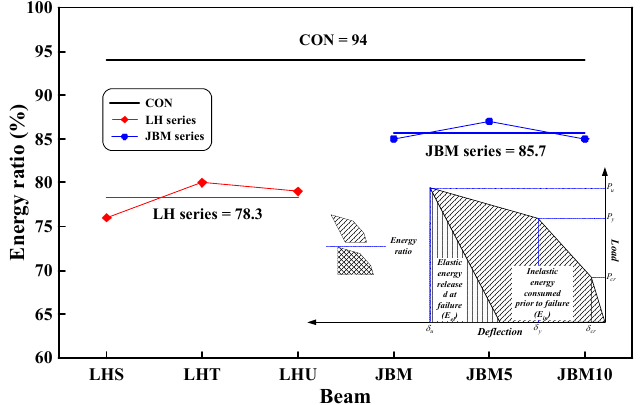
Figure 9. Variation in inelastic energy ratio. P cr , P y , P u : cracking, yield and ultimate loads; δ cr , δ y , δ u : deflections corresponding to the cracking, yield and ultimate.